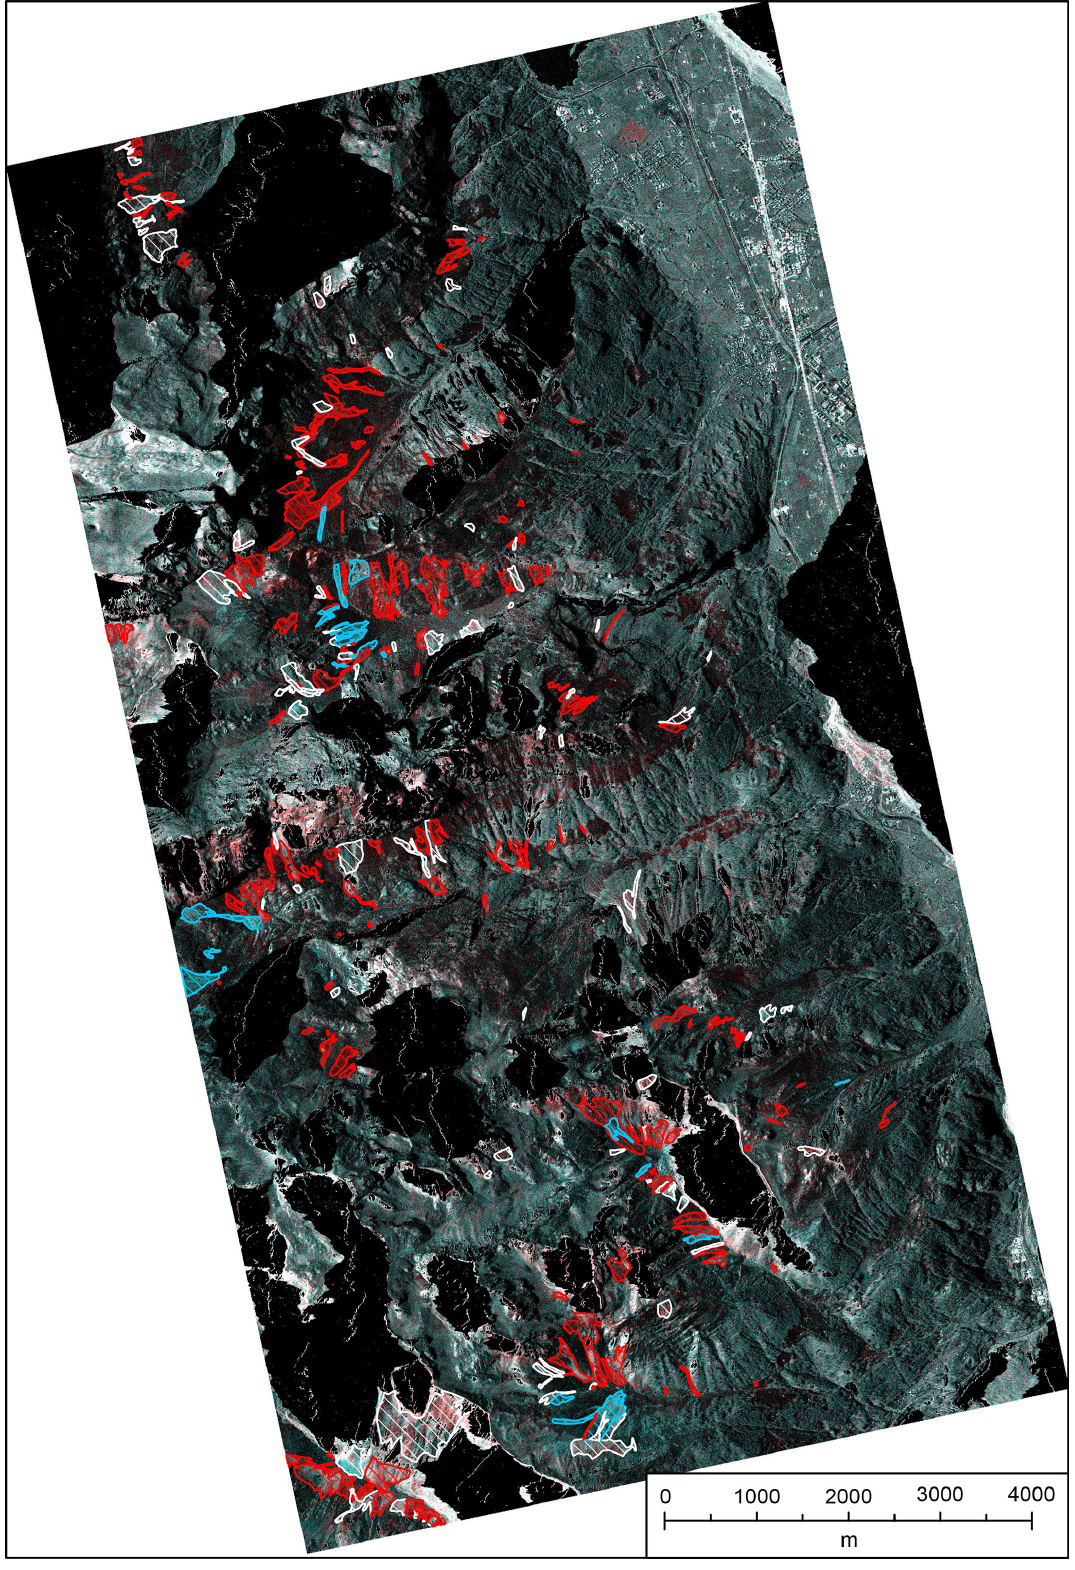
Figure A2. Full extent of the RGB composite image TSX 2017-31-12 vs. 2018-01-11 with manually mapped avalanches. New avalanches are red, old avalanches are blue, and unsure avalanches are white. Areas in the radar layover and shadow are masked out (black). TerraSAR-X image orthorectified with the swissALTI3D © 2019 swisstopo (JD100042), reproduced with the authorization of swisstopo